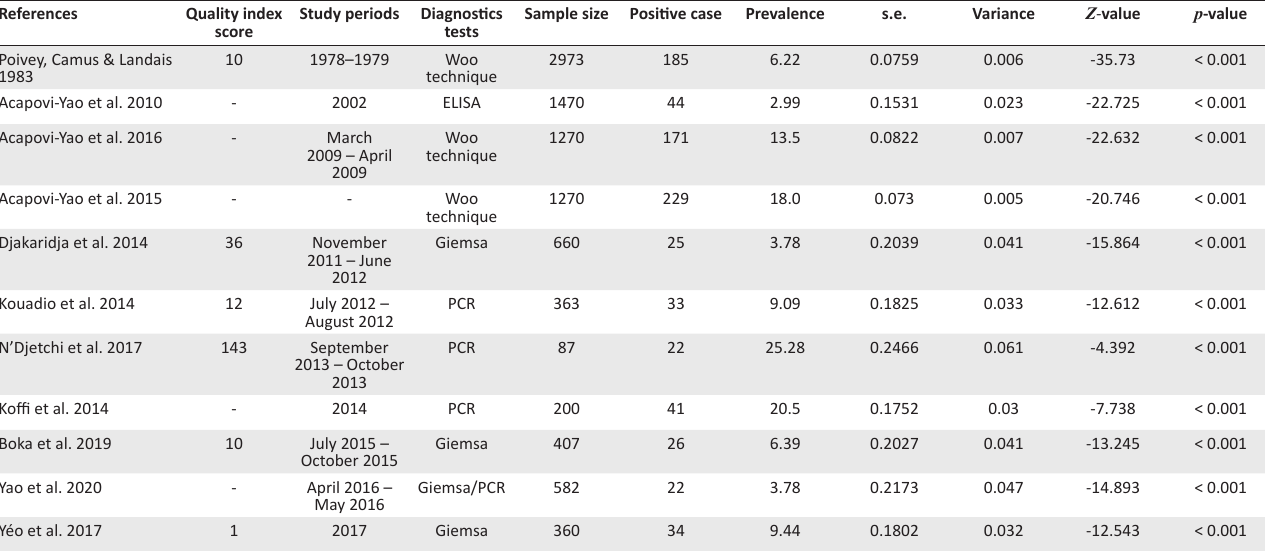
TABLE 1: Studies included in the quantitative synthesis.